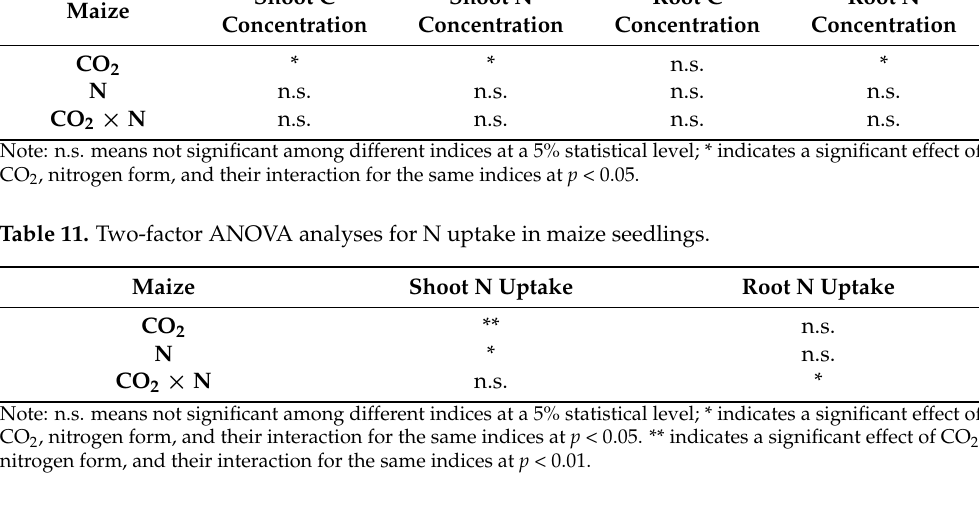
Table 10. Two-factor ANOVA analyses for C and N concentrations in maize seedlings. Table 11. Two − factor ANOVA analyses for N uptake in maize seedlings. Shoot C Maize Maize